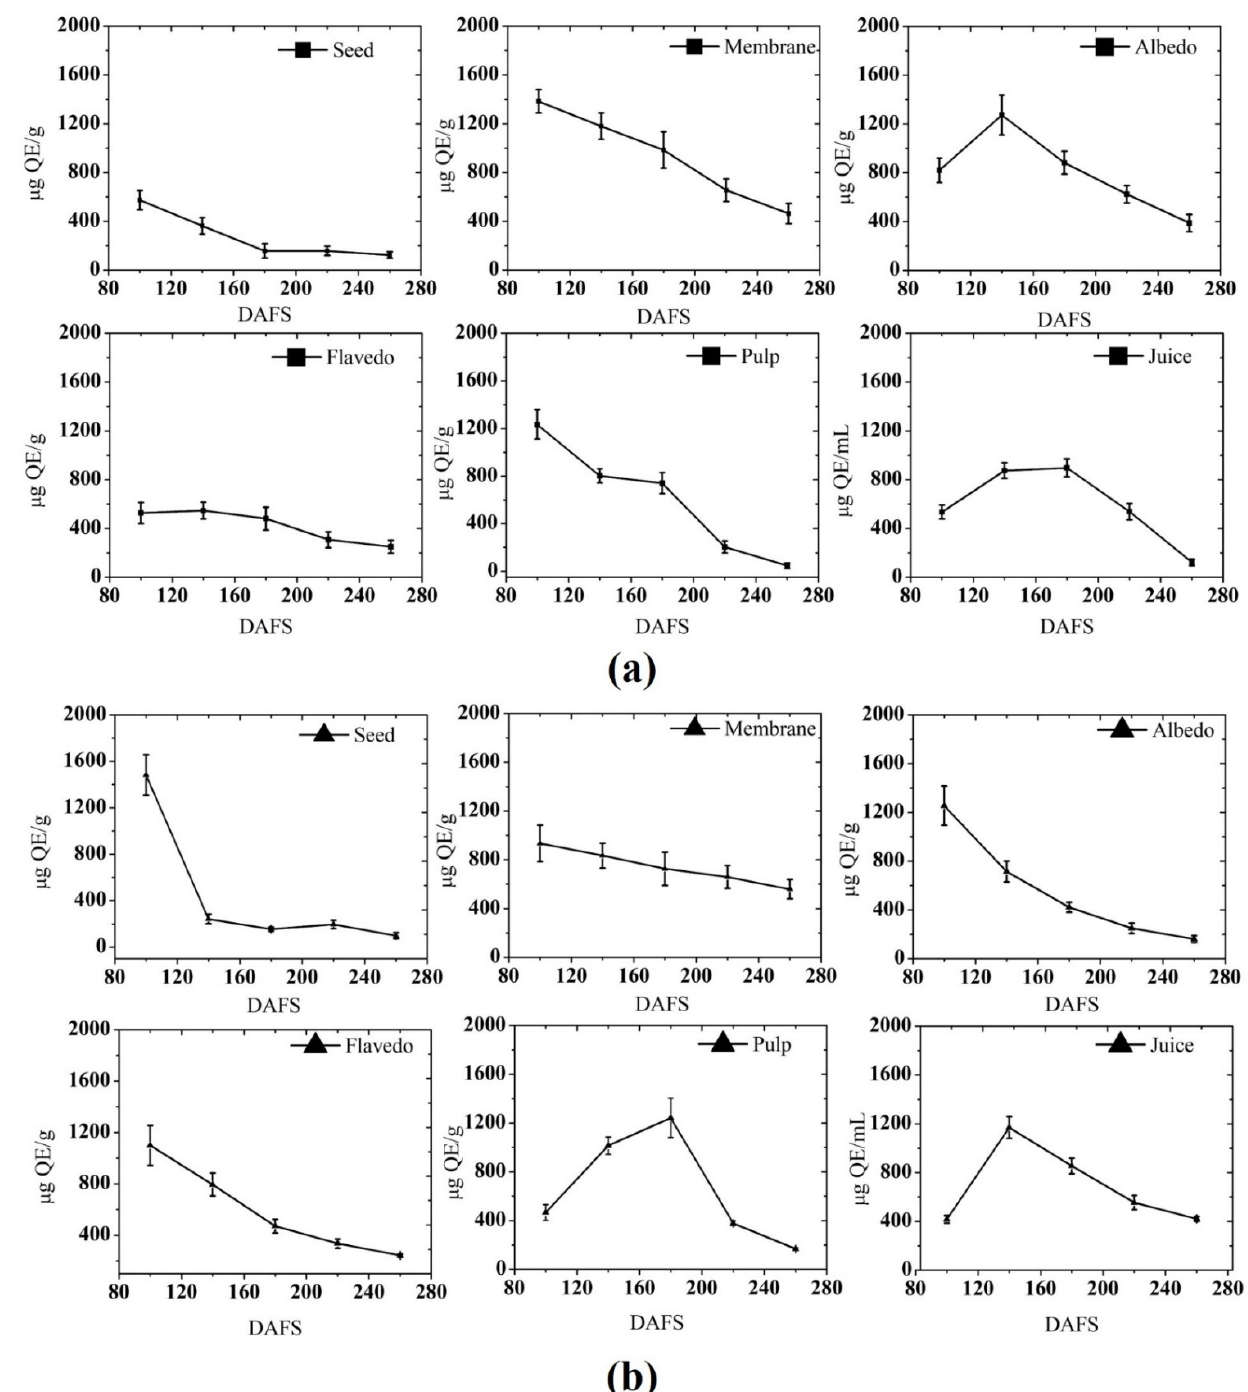
Figure 3. Total flavonoid content in ( a ) 2018; and ( b ) 2019. DAFS; days after fruit set.